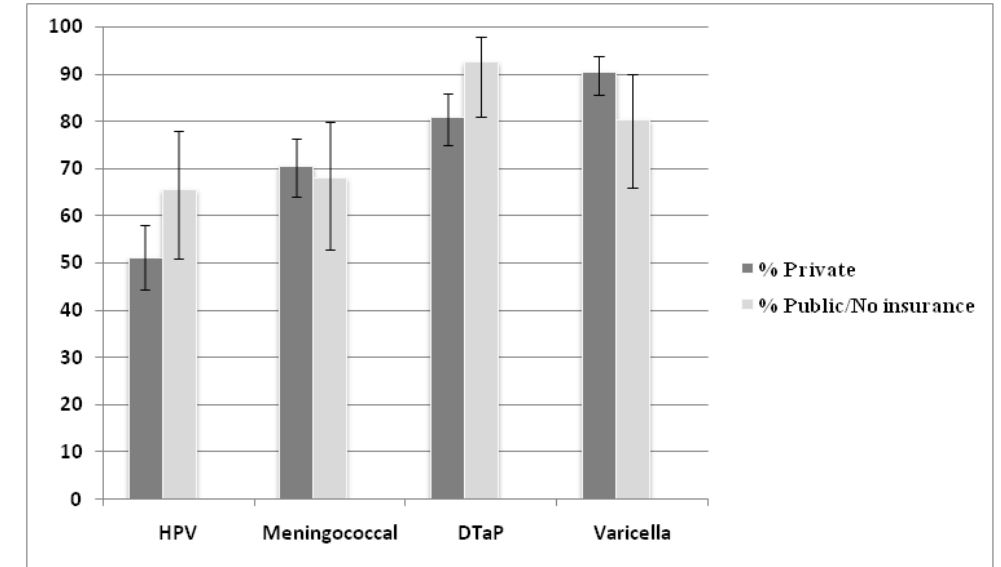
* Error bars represent 95% confidence